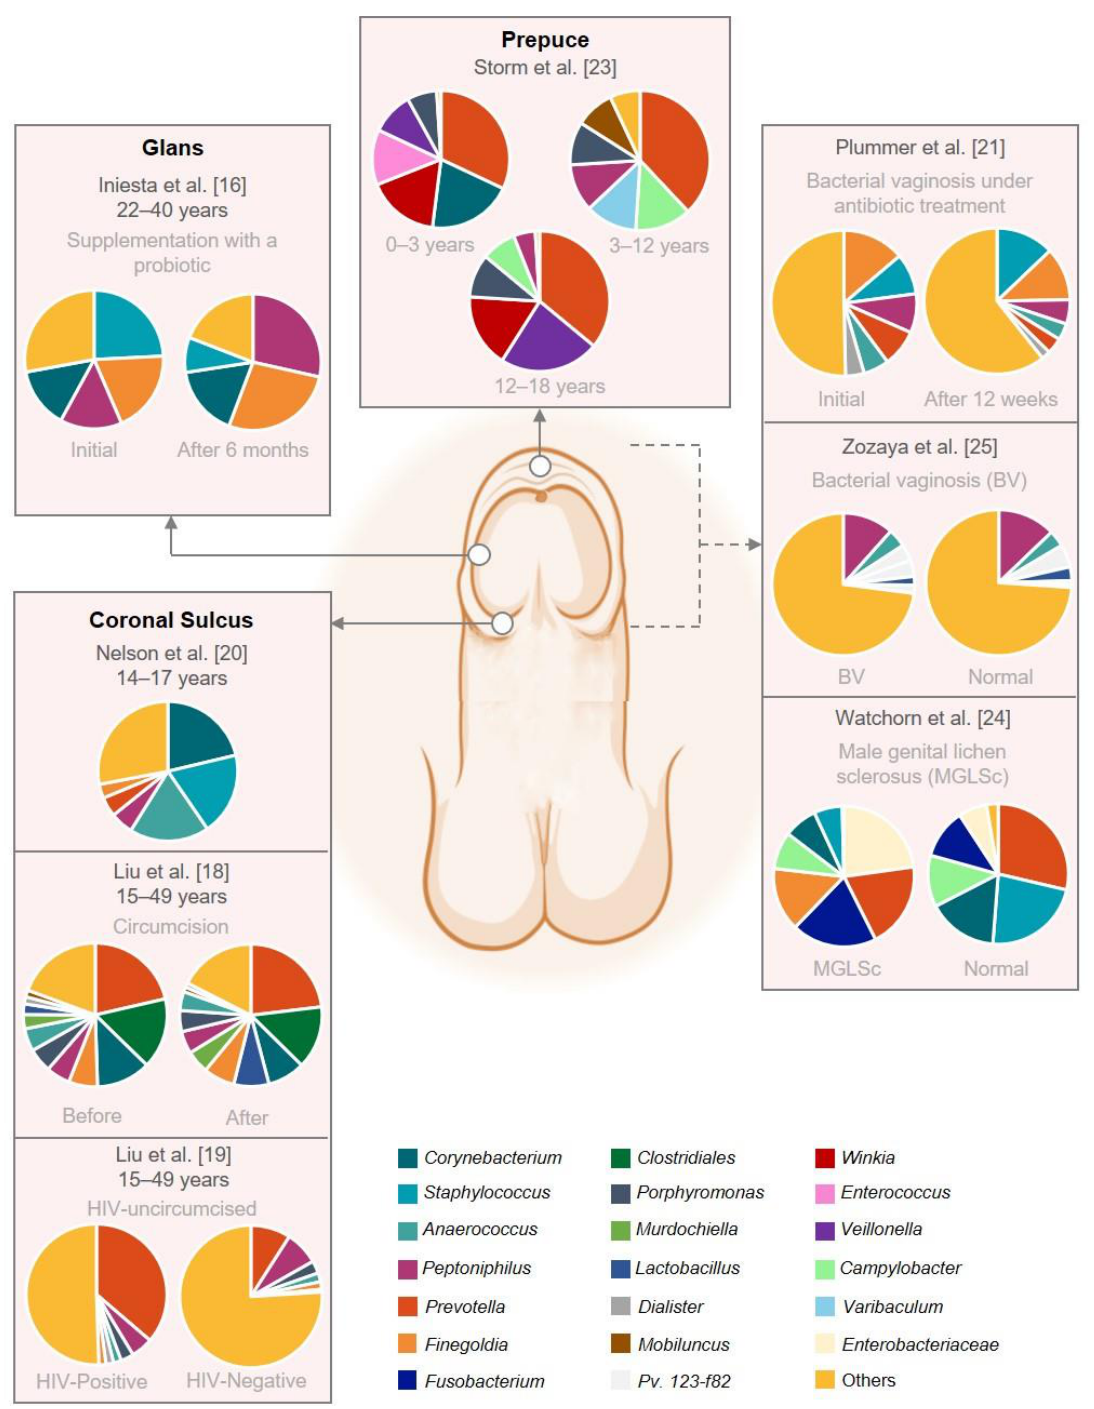
Figure 2. Graphical representation of the male genital mucosa microbiome composition. This figure was based on eight studies that reported the abundance on genus level. The remaining studies did not have raw abundance data available. The figure was created with BioRender.com (accessed on 16 September 2022).